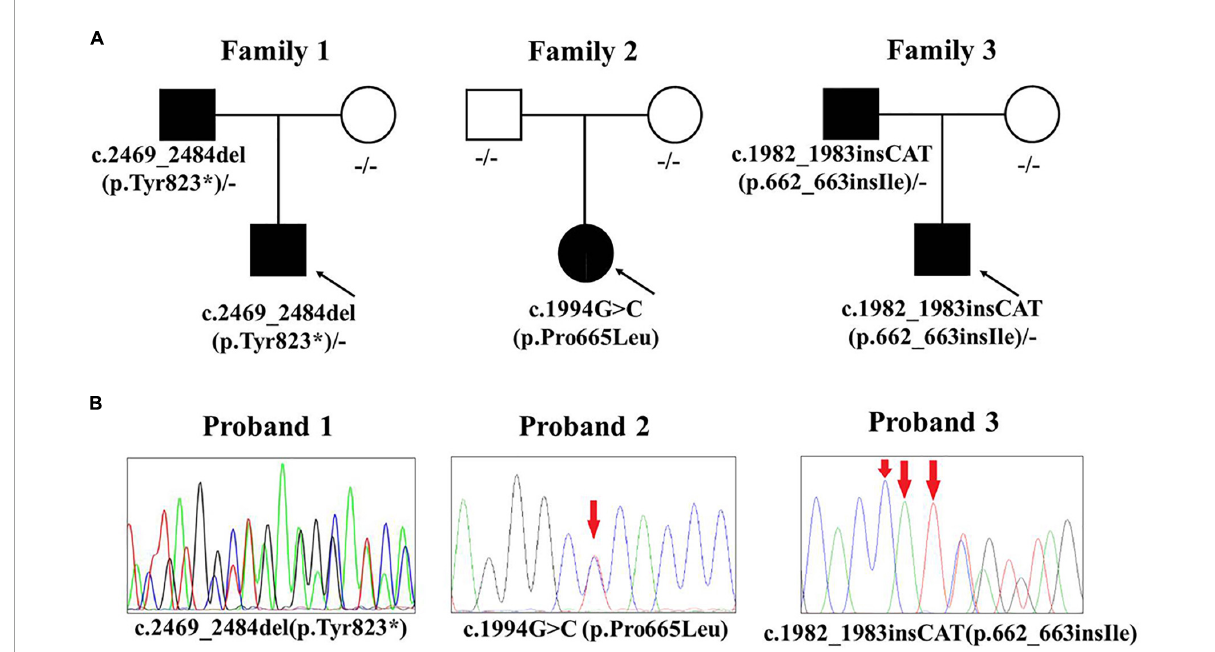
FIGURE2 KIT mutations of the three piebaldism patients. (A) Pathogenic variants and their origin in the three families. (B) Sanger sequencing results of three pathogenic